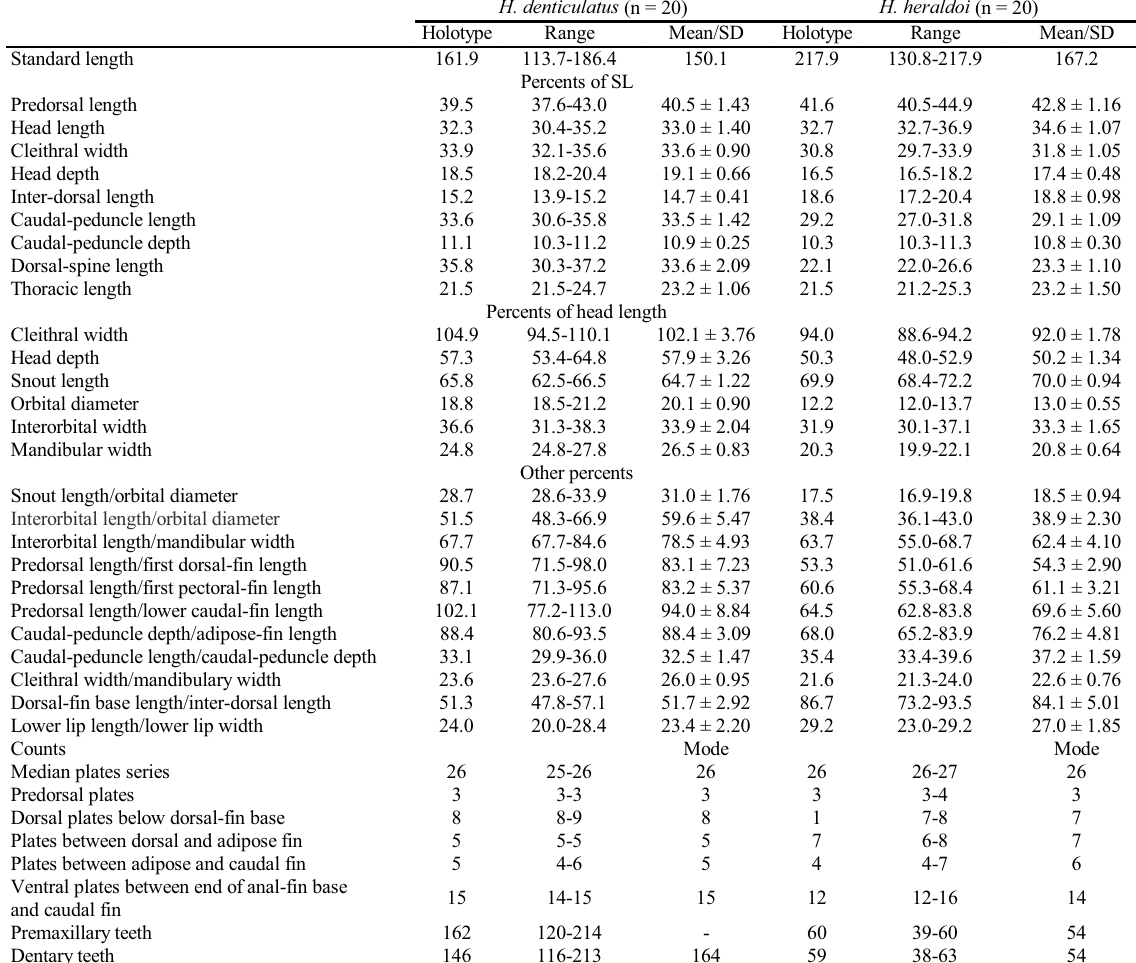
Table 1. Morphometric data and counts for Hypostomus denticulatus and H. heraldoi from the upper rio Paraná basin, Brazil. Means are presented for measurements, and modes for counts. SD = standard